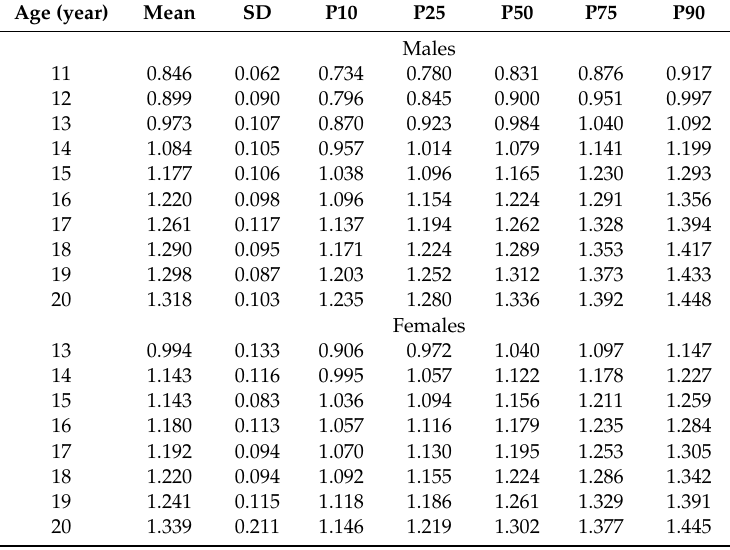
Table A2. Basic statistical parameters (mean, SD, and 10th, 25th, 50th, 75th, and 90th percentiles) of TBLH BMD (g / cm 2 ) in youth male and female